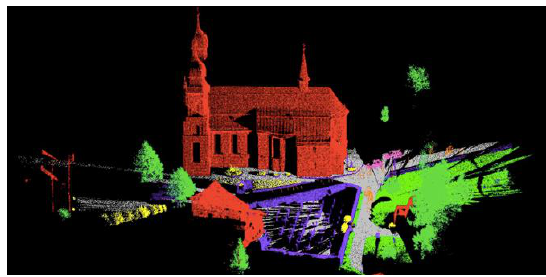
Figure 1: Example of a segmented and classified point cloud